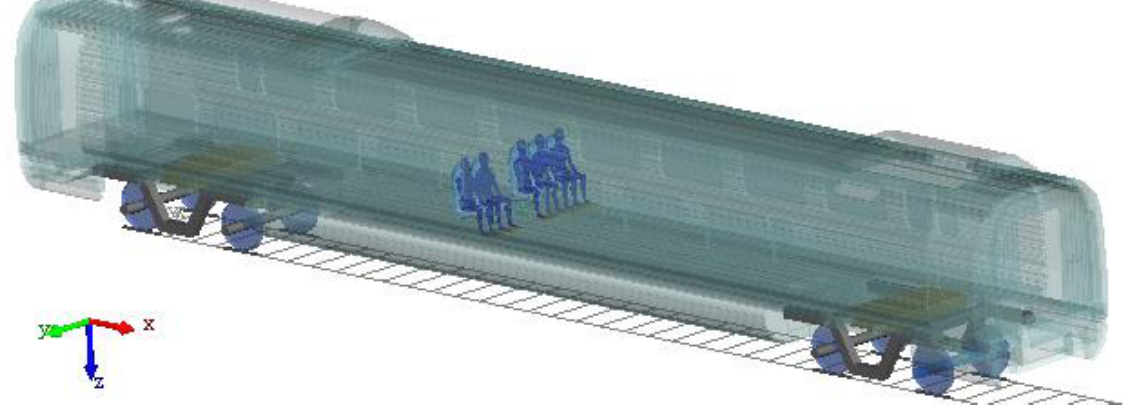
Figure 9. Train seat – human body coupled dynamics model.